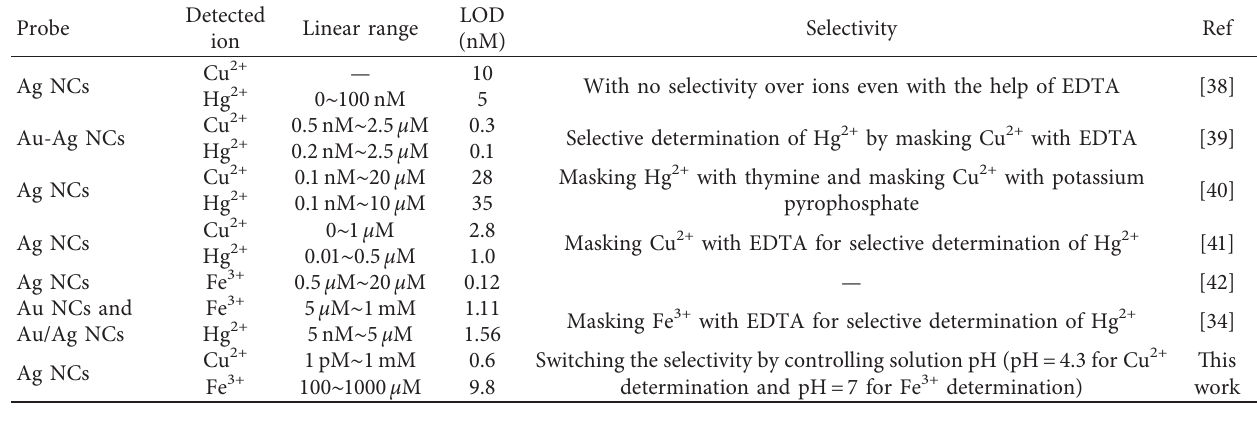
Table 2: Comparison of Ag NCs probe for the detection of Cu 2+ and Fe 3+ with previously reported fluorescent-based probes in aqueous